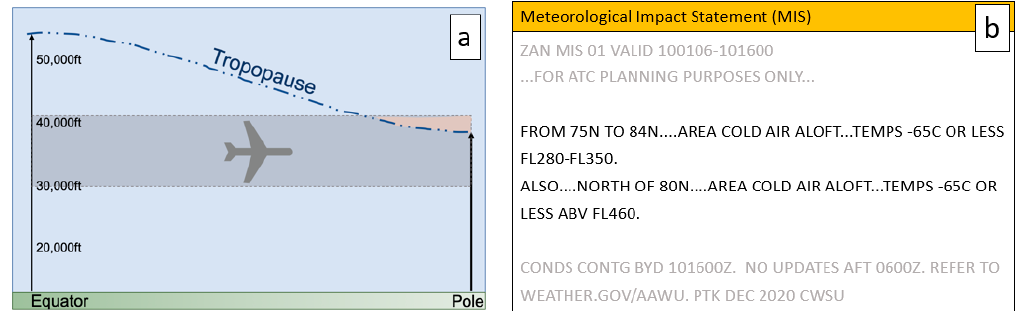
Figure 1. ( a ) Illustration of how the tropopause height is lower in the poles. ( b ) Flights are often diverted when widespread Cold Air Aloft (CAA) is present in the upper troposphere and lower stratosphere, which coincides with commercial flight zones in high latitudes. Air temperatures below − 65 °C can cause water within the jet fuel to freeze and common fuels begins to form wax crystals, which can reduce fuel efficiency or pose a safety hazard.